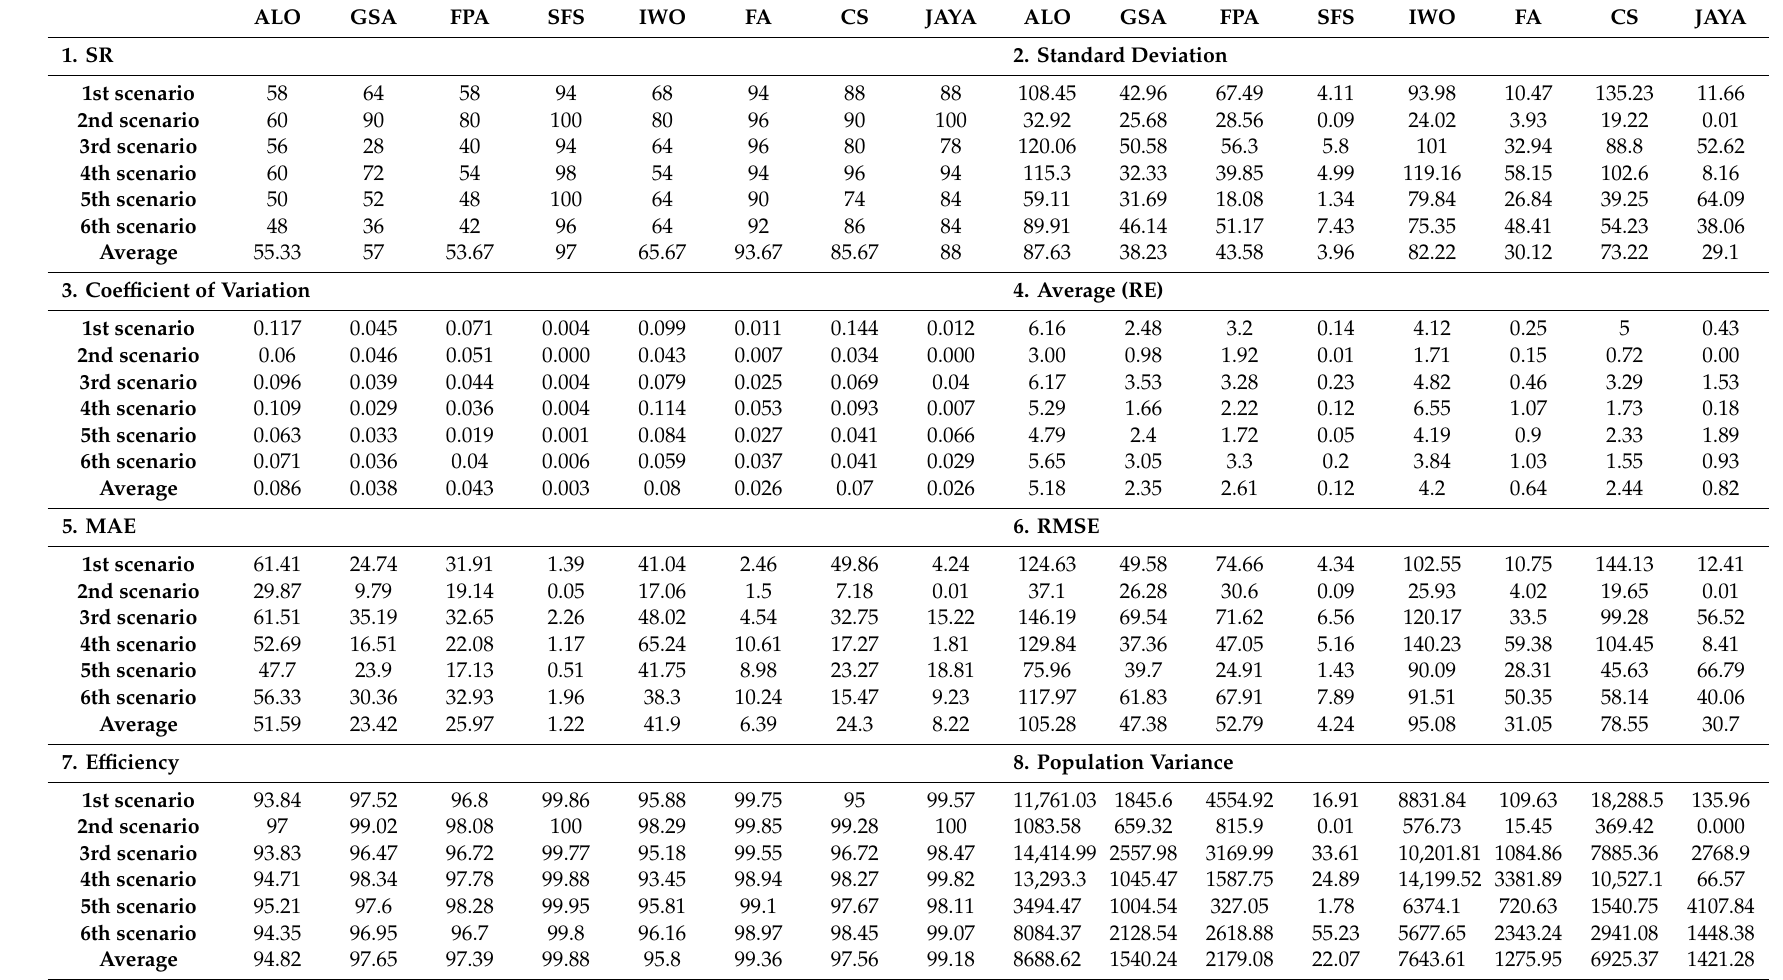
Table 3. Statistical performance of di ff erent considered global MPPT